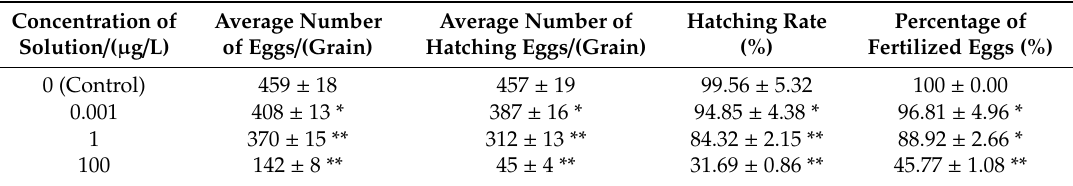
Figure 1. The oviposition of silkworms from different treatment groups: ( a ) control group, ( b ) 0.001 mg/L of pyriproxyfen treatment group, ( c ) 1 mg/L of pyriproxyfen treatment group and ( d ) 100 mg/L of pyriproxyfen treatment group. Table 2. E ff ects of pyriproxyfen exposure on the reproduction of